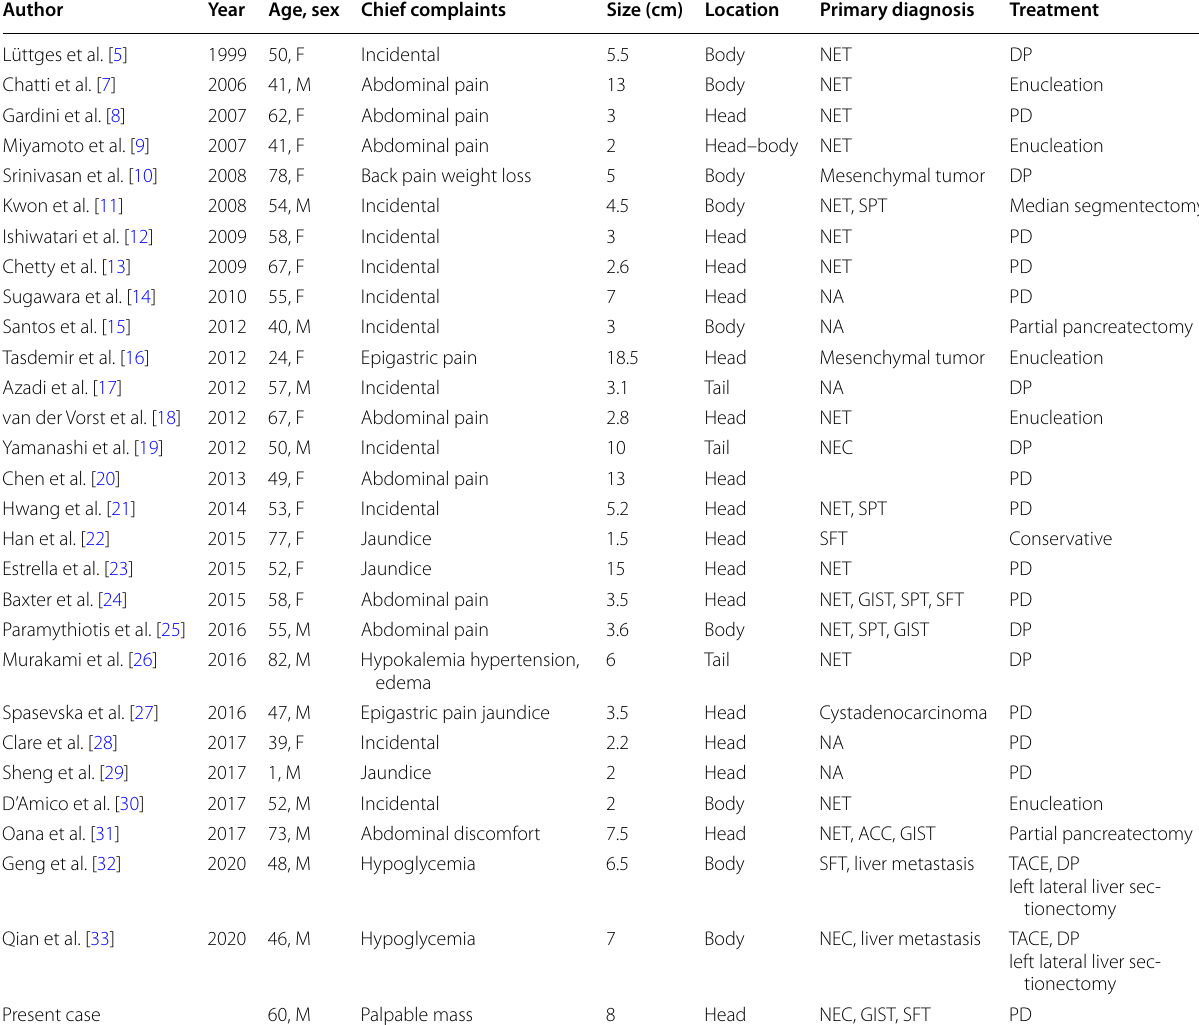
Table 1 Patient characteristics of pancreatic solitary fibrous